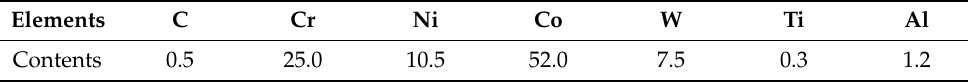
Table 1. The main constituent elements and contents of DZ40M alloy (wt.%).